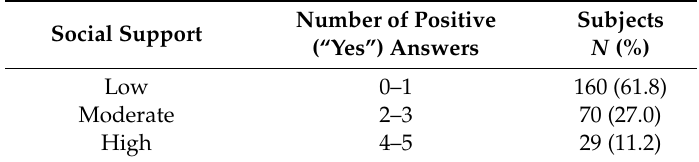
Table 1. Categorization of self-perceived social support according to the number of positive answers in the